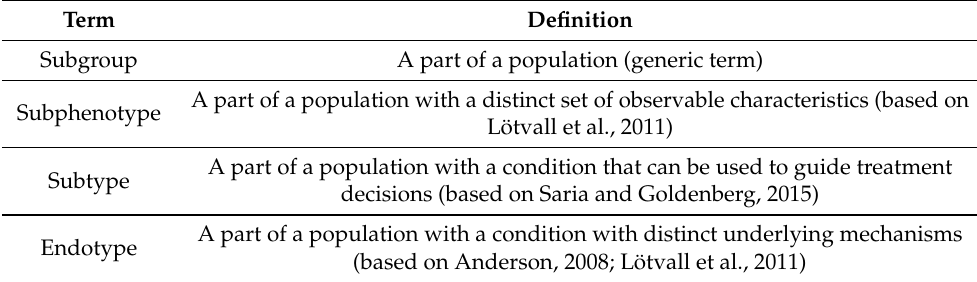
Table 1. Subgrouping rules’ semantic distinctions; approved excerpt from Genitsaridi, 2021.